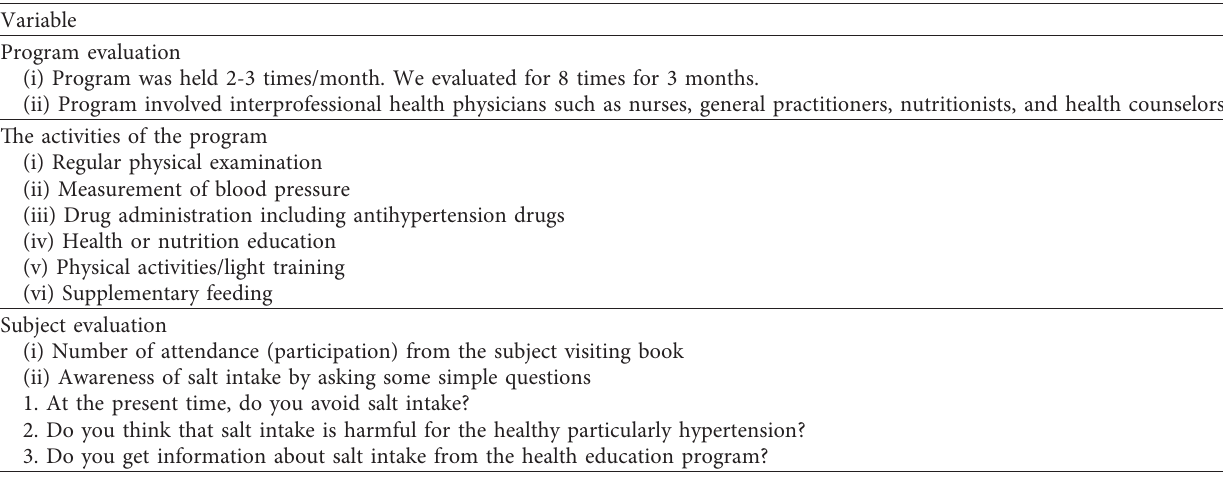
Table 1: Evaluation of salt intake at elderly public health program.